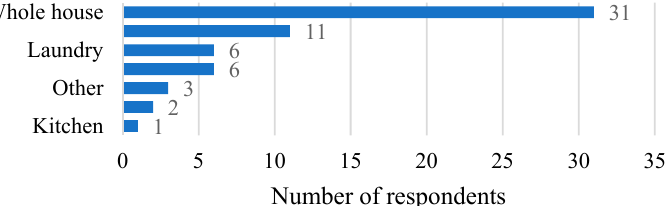
Figure 3. Access of dogs indoors reported by respondents to a questionnaire about relationships with dogs in nine Aboriginal communities in New South Wales, Australia.